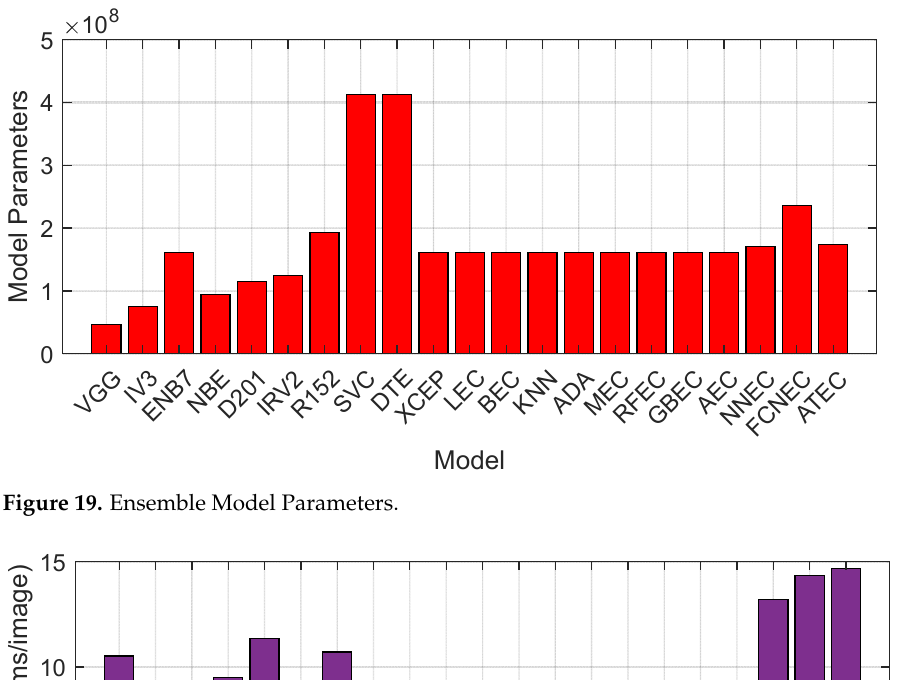
Figure 19. Ensemble Model Parameters.